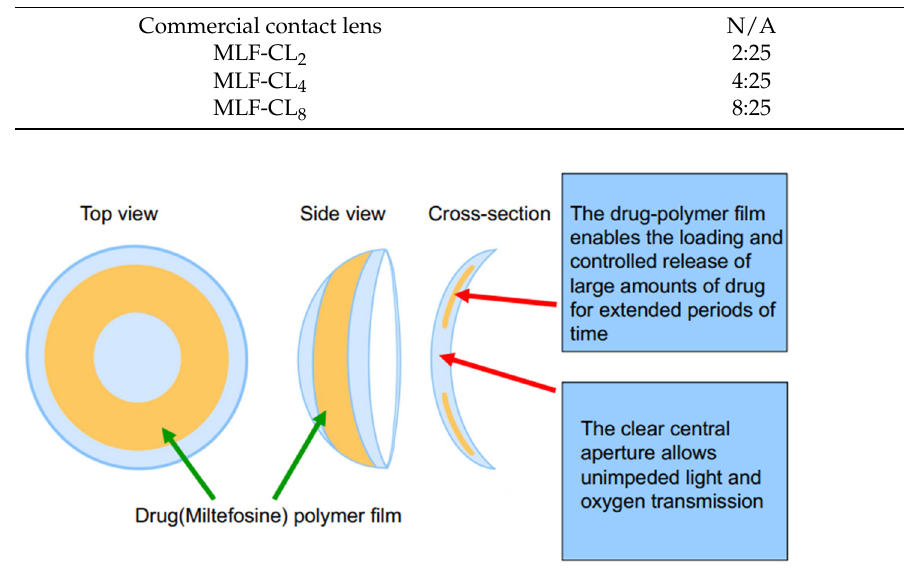
Table 1. MLF-CL formulations. Formulation Name